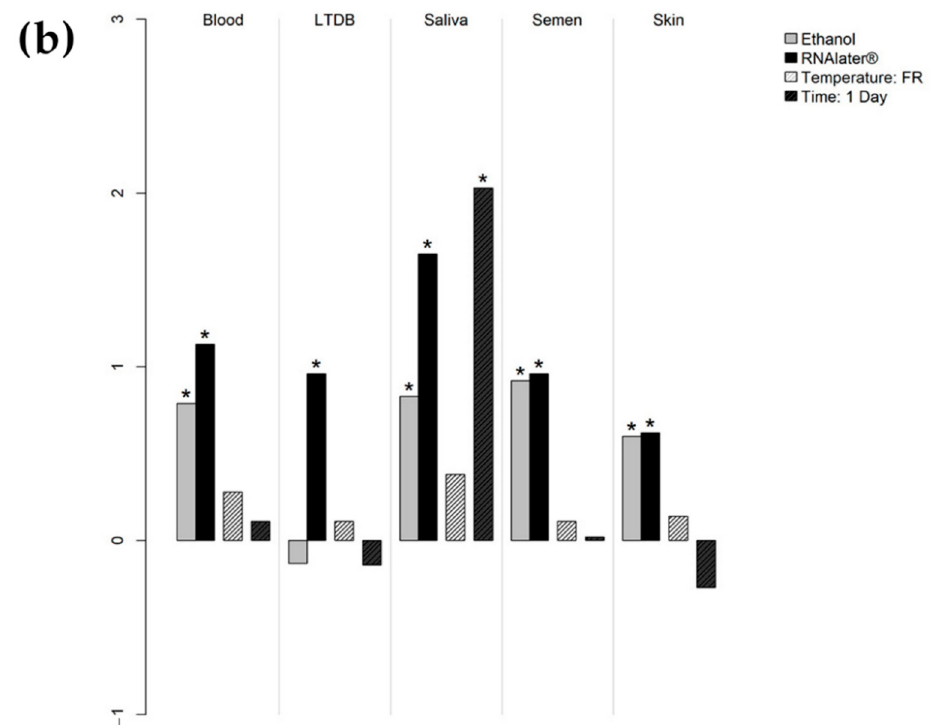
Figure 2. Coefficients on the y -axis (log scale) represent the mean increase or decrease in the average peak height (measured in rfu) of the tissue-specific markers ( a ) and the housekeeping genes ( b ) when different moistening agents, storage temperatures (FR: frozen), and storage times before processing were applied to collection swabs, compared to the standard procedure (i.e., swabs moistened with water and stored at room temperature for 7 days before extraction). Significant p -values are marked with an asterisk. LTDB: luminol-treated diluted blood.